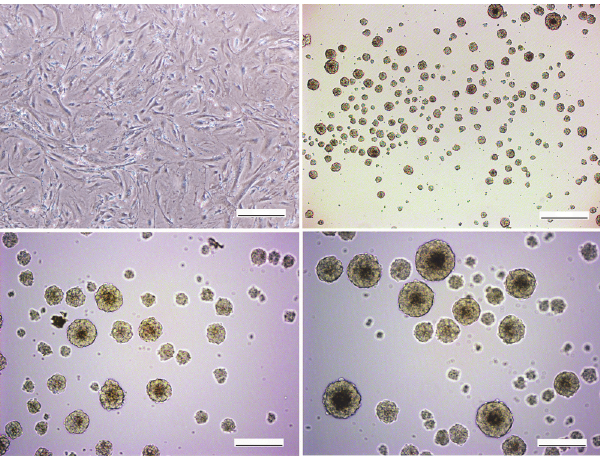
Fig 3. Generation of iNSCs. MEFs in monolayer culture for 7 days, no significant morphological change was observed (A). MEFs in low-attachment culture for 7 days, neurosphere-like clones were formed (B). iNSCs morphology was maintained over prolonged passaging at P8(C) and P20 (D) iNSC were similar to that of wt- NSCs. Scale bars = 200 μ m (A, C, D), 400 μ m